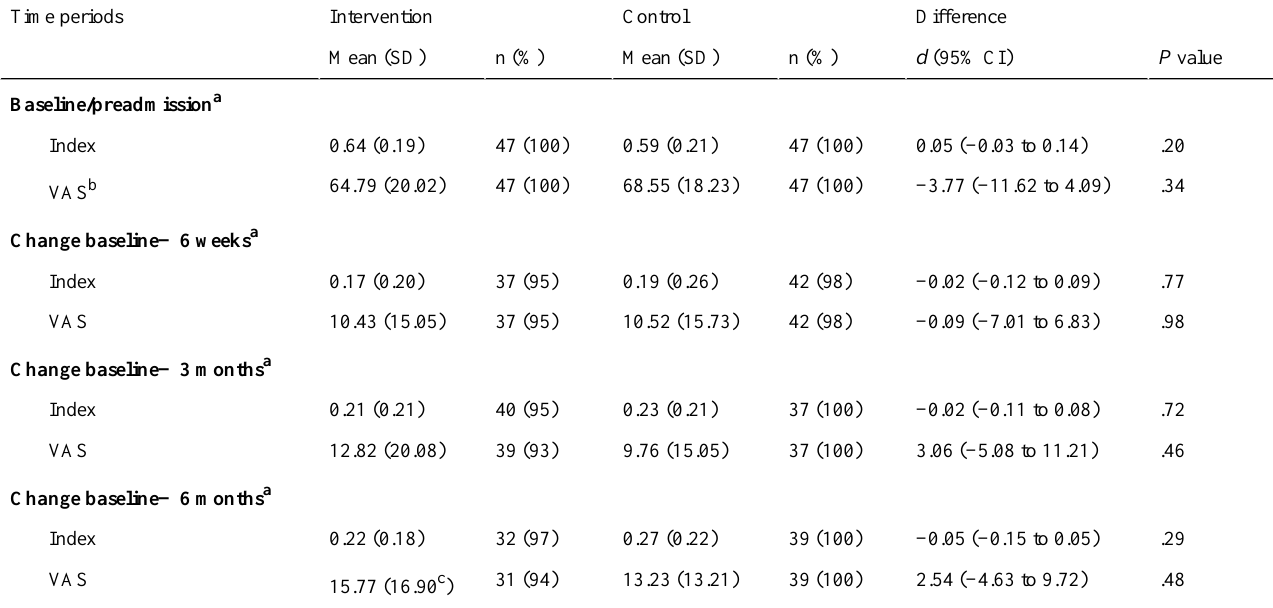
Table 3. Secondary outcome assessment 5-level 5-dimension quality of life measure. DifferenceControlInterventionTime periods